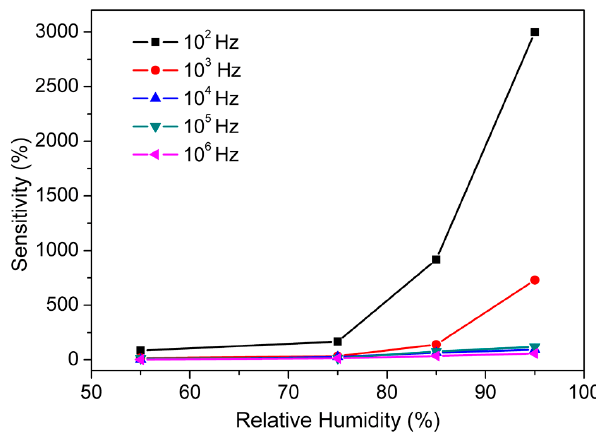
Figure 6. The variations of capacitance with frequency at different humidity condition (33%–95% RH) for CMFTO based humidity sensor at 25 °C. Inset image represents the variation of capacitance with frequency at different RH in logarithmic scale (log( C ) vs. log(RH)). Note: The value of capacitance increases with increased % RH, but decreases with increased frequency. The decreased rate is faster in lower frequency (<10 4 Hz) and higher humidity range (>85% RH).